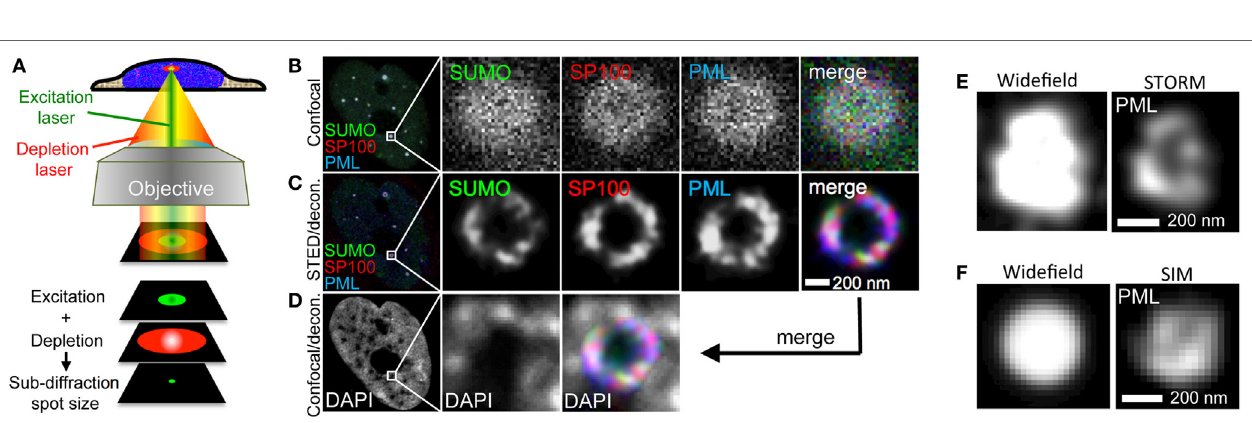
FigURe 9 | Optical tweezer (OT) as a tool to analyze PML nuclear body assembly. (A) Schematic depiction of erythrocyte-mediated force application (EMFA) based on OTs. Polyethylenimine coated erythrocytes attach unspecifically to the surfaces of the adherent target cells. Erythrocytes serve as very efficient “force transmitting devices” for axial force application on cells. The cell layer is moved into the region of the desired position in such a way that the laser focus (yellow ellipse) locates slightly below the erythrocyte. Immediately after switching on the laser the erythrocyte is pulled toward the focus due to the gradient force of the laser light, which causes a brief physical force onto the cell. The experimental setup used here consists of a continuous wave (cw) diode pumped Nd-YAG-laser (Spectra Physics) emitting at 1064 nm. The laser beam is coupled into an inverted confocal laser scanning microscope (LSM 510, Carl Zeiss Jena) and was focused via a high numerical aperture objective (100 × , 1.30 NA) into the object plane. (B) U2OS cells expressing EGFP-tagged PML-IV were subjected to EMFA as shown in (A) . In phase contrast (PhC) imaging, the position of the nucleus relative to erythrocytes can be monitored during the course of the experiment (upper panels). The behavior of PML nuclear bodies was monitored by confocal sectioning (middle panels, images show maximum intensity projections). The nuclear region of force application is shown as a magnified view in the bottom panels. Arrowheads indicate de novo formation of PML NBs. Scale bar, 5